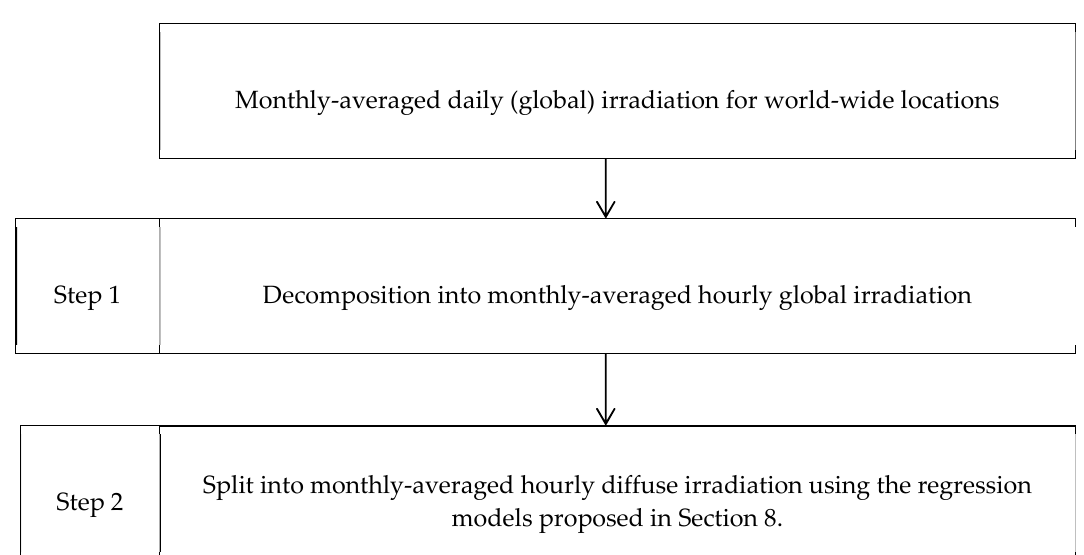
Figure 1. Computational chain to get all manner of solar energy estimations [59–61]. Source: http://eosweb.larc.nasa.gov.